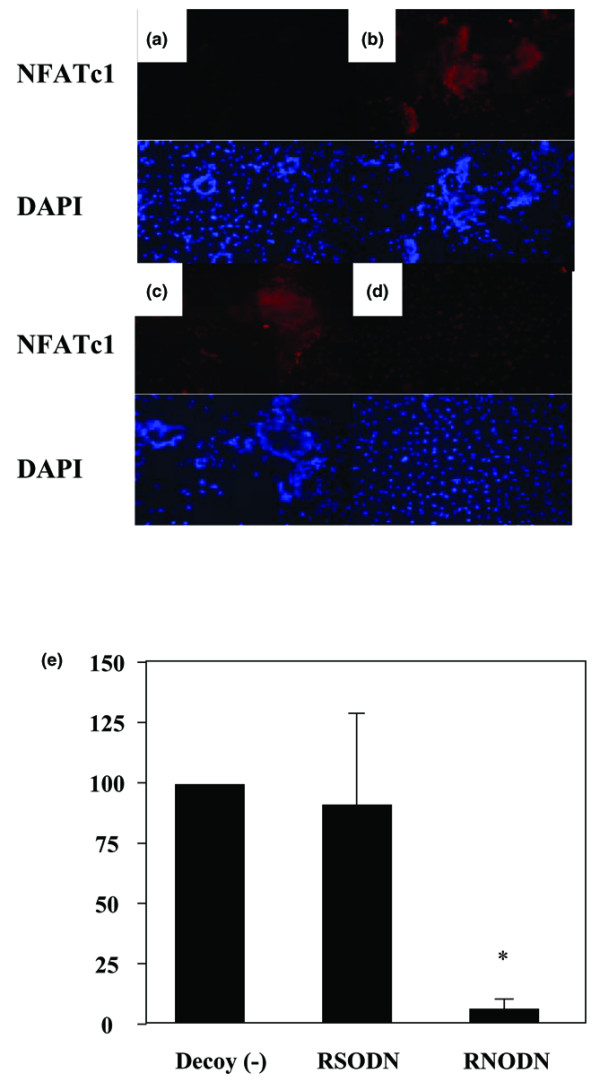
Expression of NFATc1 protein in osteoclast precursor cells. (a-d) Immunohistochemistry of NFATc1 protein with specific antibody in osteoclast precursor cells. Bone marrow macrophages were incubated with M-CSF/RANKL for 48 hours after incubation with ribbon-type scrambled decoy oligodeoxynucleotide (RSODN) (c) or ribbon-type NF-κB decoy oligodeoxynucleotide (RNODN) (d), or were untreated alone (b). (a) Without reaction with primary antibody. The expression of NFATc1 by immunofluorescence is shown in each upper panel. Nuclei stained with 4',6-diamidino-2-phenylindole are shown in each lower panel. Original magnification × 100. (e) Measurement of fluorescent area of osteoclast precursor cells. The areas of fluorescent cells in RSODN-treated and RNODN-treated groups are shown as percentages over that of the untreated group. (n = 5 per group; *p < 0.001 compared with the RSODN-treated group.)